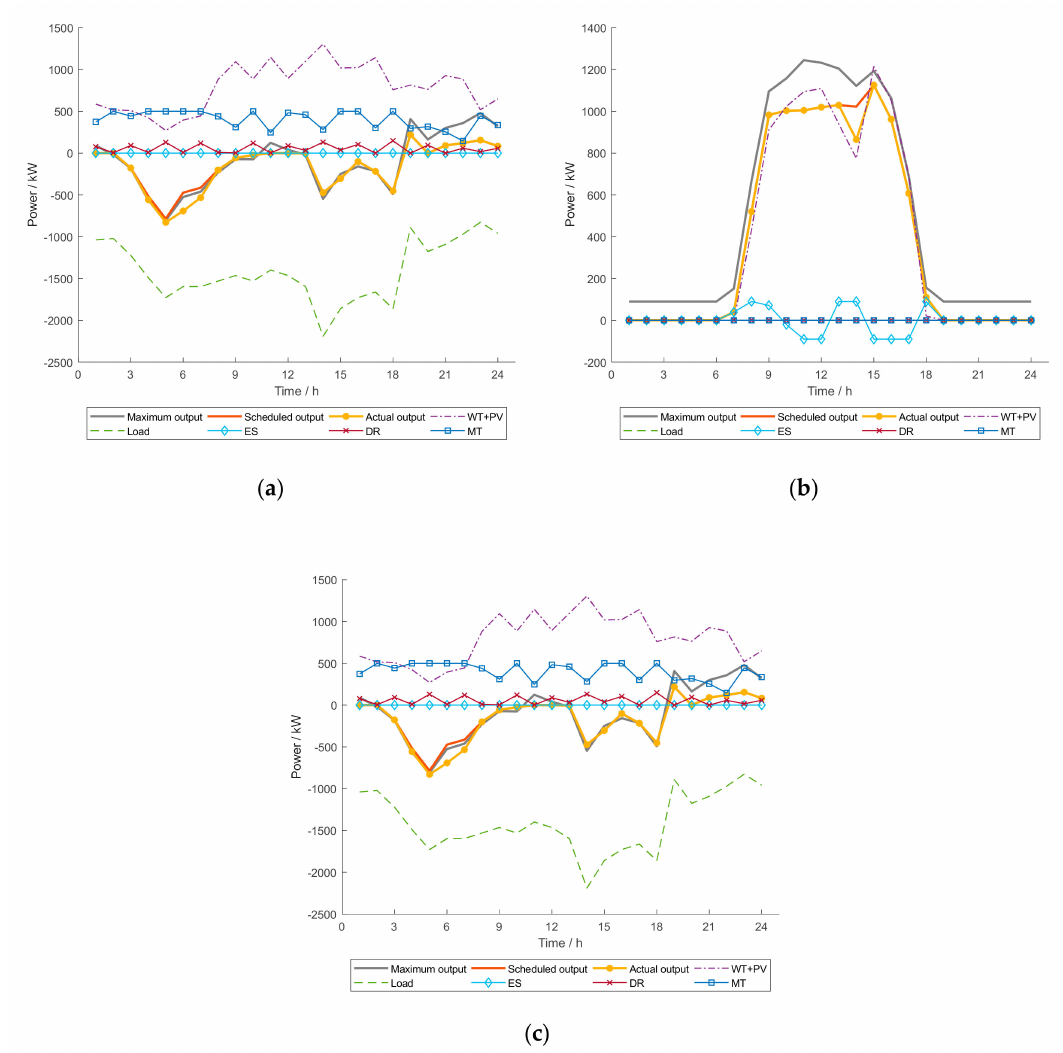
Figure 6. Local scheduling results of VPPs: ( a ) VPP 1 ; ( b ) VPP 6 ; ( c ) VPP 7